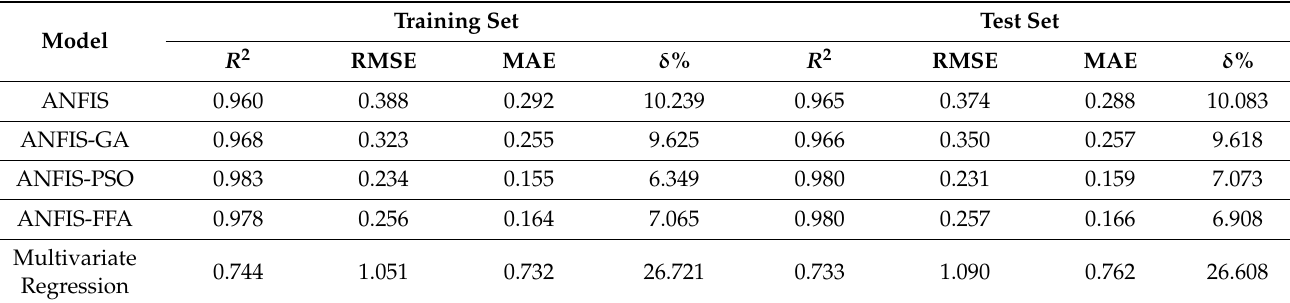
Table 7. Overall performance evaluation for all the test data